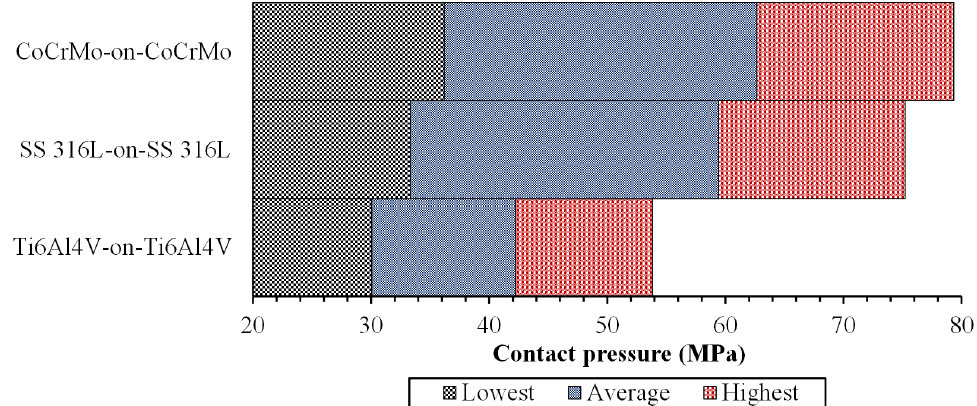
Figure 6. Comparison for the highest, average, and highest contact pressures of the maximum values for all phases.